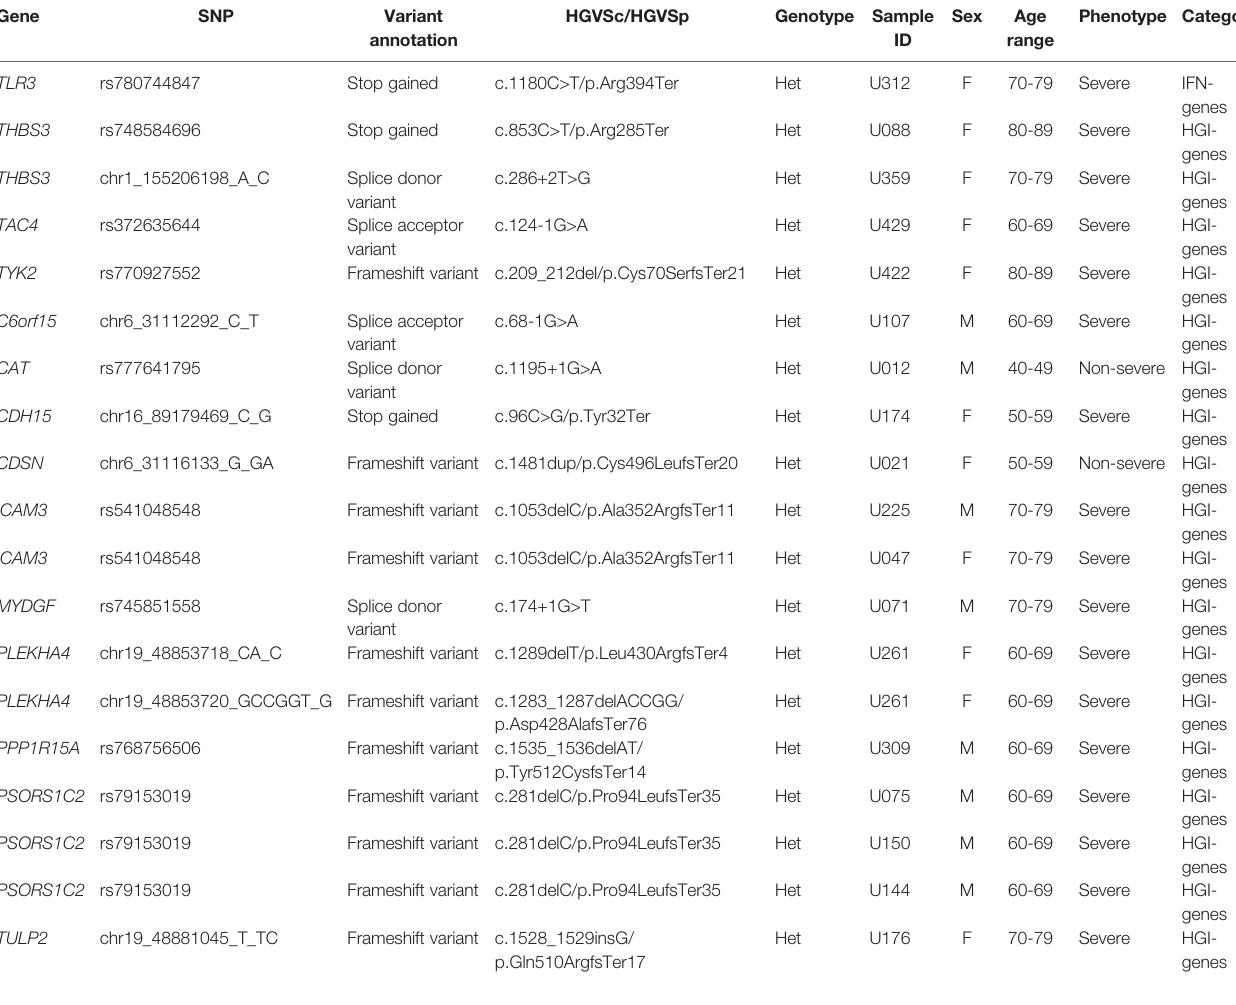
TABLE 2 | The pLoF variants identi fi ed in Covid-19 patients in 159 candidate